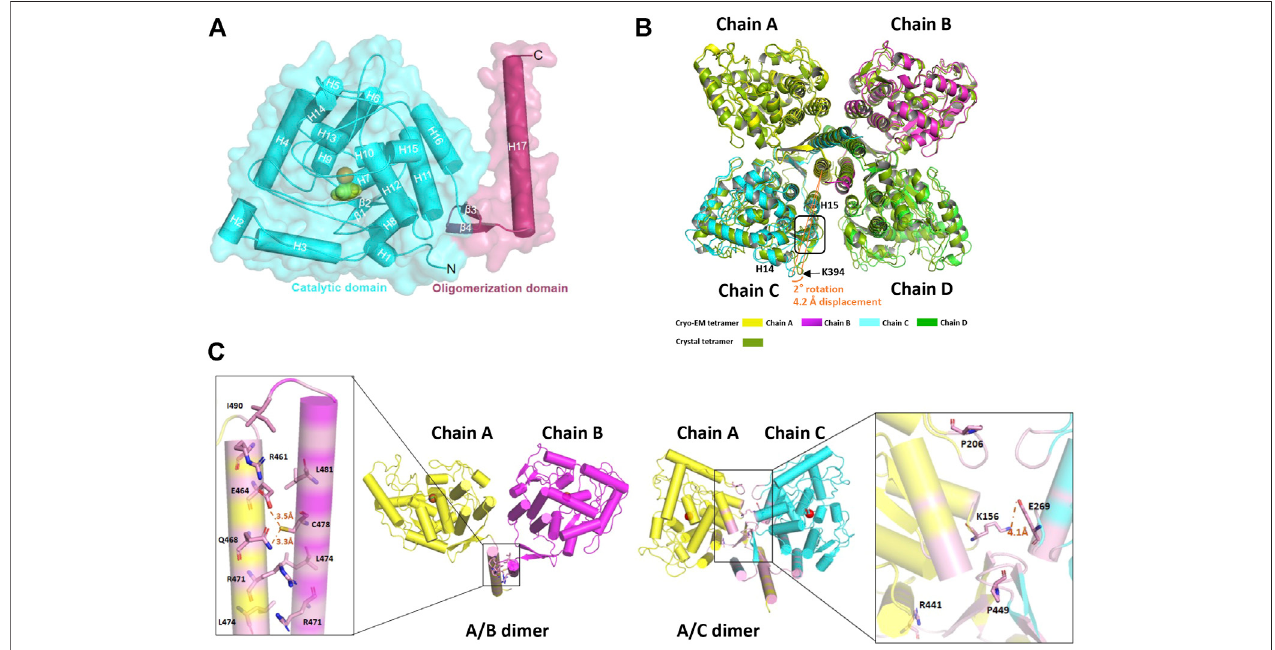
FIGURE 2 | Structure analysis of human tryptophan hydroxylase 2 (TPH2). (A) cartoon display of TPH2 monomer. The catalytic domain is colored cyan, while the oligomerization domain is colored warm pink. (B) superposition of the cryo-EM structure with the crystal structure of TPH2 (PDB entry: 4V06). The cryo-EM structure of TPH2 intetrameriscoloredbychain, while thecrystalstructure iscoloredsplitpea.The tetramerofthecrystalstructureisobtained bydimer using thesymmetryoption. The arrow and curve indicate the different secondary structures and the rotation they adapted. (C) interfaces analysis of TPH2 dimers. The left shows the